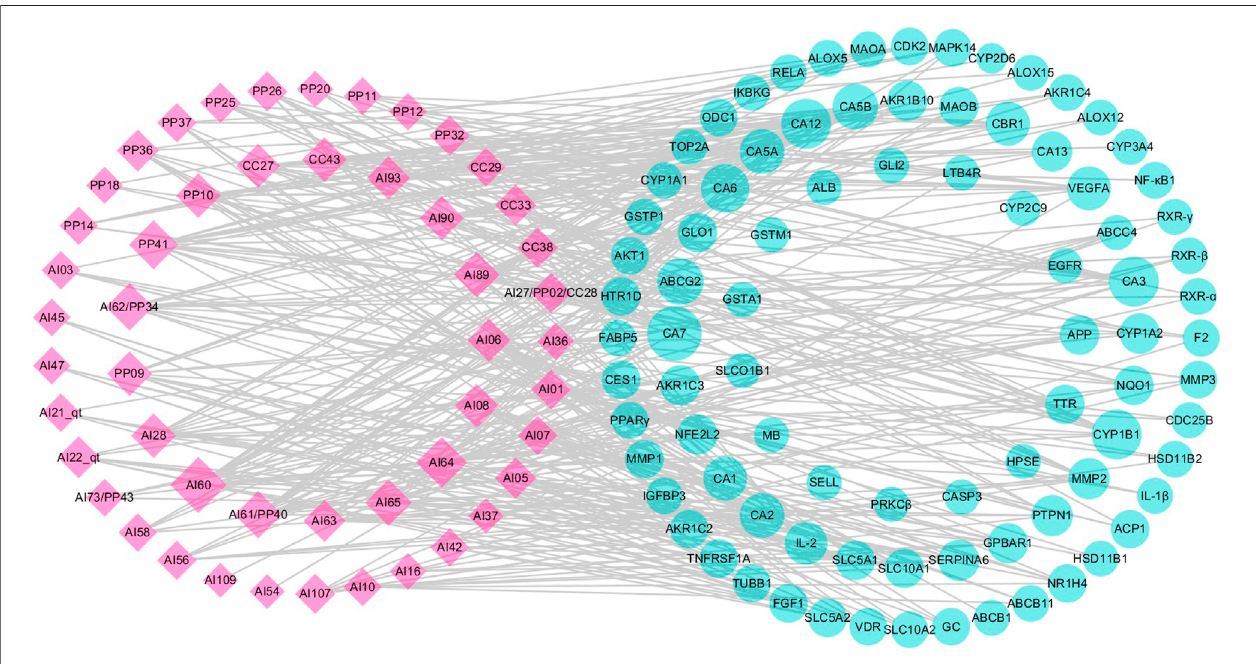
FIGURE 2 | Candidate compound – potential target (cC-pT) network associated with liver injury based on the active ingredients from LCS. Note: the pink diamond and cyan circle nodes represent candidate compounds and potential targets, respectively.